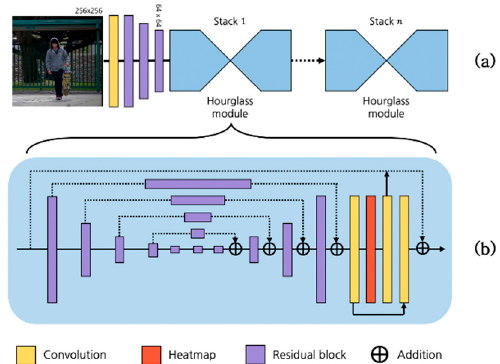
Figure 1. ( a )Originalhourglassnetworkarchitectureand( b )hourglassmodule. Thehourglassarchitecture Figure 1. ( a ) Original hourglass network architecture and ( b ) hourglass module. The hourglass is composed of hourglass modules stacked n architecture is composed of hourglass modules stacked 𝑛 times.